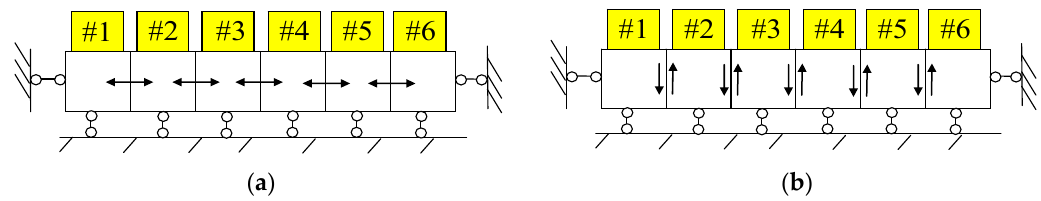
Figure 17. Diagram of simplified models of six units: ( a ) Horizontal vibration; and, ( b ) Vertical vibration.